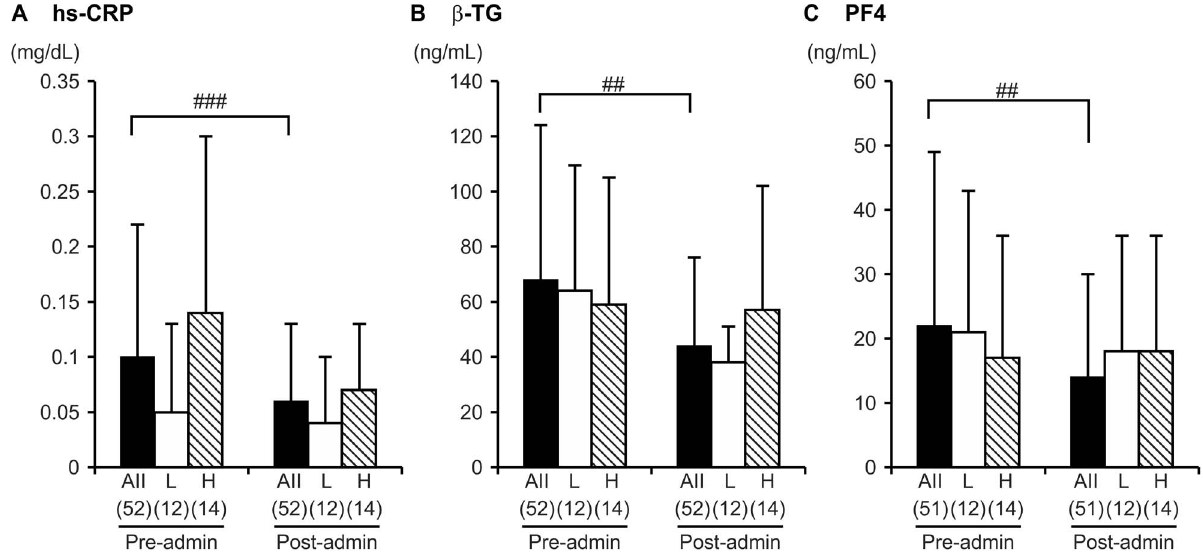
Figure 2. Inflammatory and platelet activity markers before and after pitavastatin treatment. Mean 6 standard deviation is shown. H indicates the group with homocysteine values above the median (8.6 m mol/L), L indicates the group with homocysteine values , 8.6 m mol/L. The number of subjects is indicated in parentheses. a) high-sensitivity C-reactive protein (hs-CRP), b) b -thromboglobulin ( b TG), and c) platelet factor 4 (PF4). Pre- and post-pitavastatin values were compared by Wilcoxon signed-rank test. ## p , 0.01, ### p , 0.001.